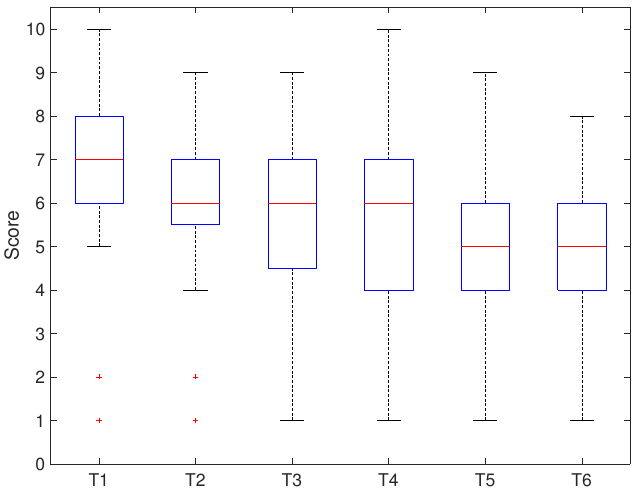
Figure 13. Scores of each assignment task (last course).